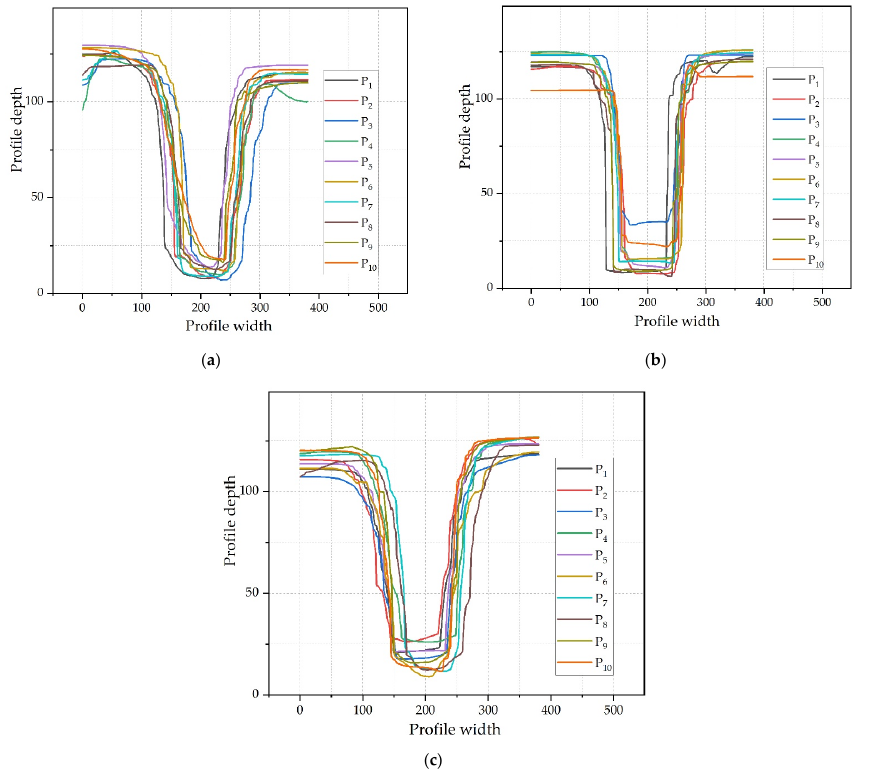
Figure 4. Microstructure profile: ( a ) cavity thickness is 0.3 mm; ( b ) cavity thickness is 0.5 mm; and ( c ) cavity thickness is 0.7 mm.